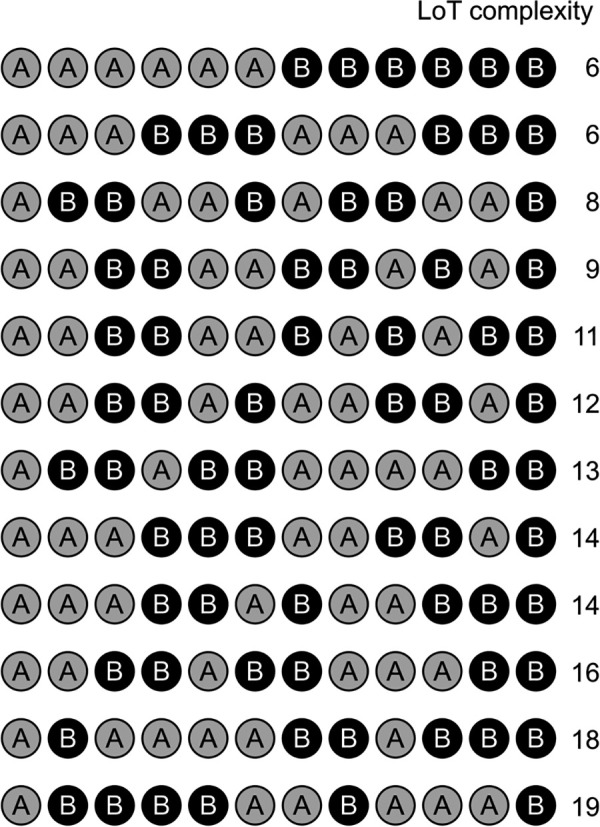
Twelve 12-item sequences used in experiment 2, with their corresponding LoT complexity value (in bits).